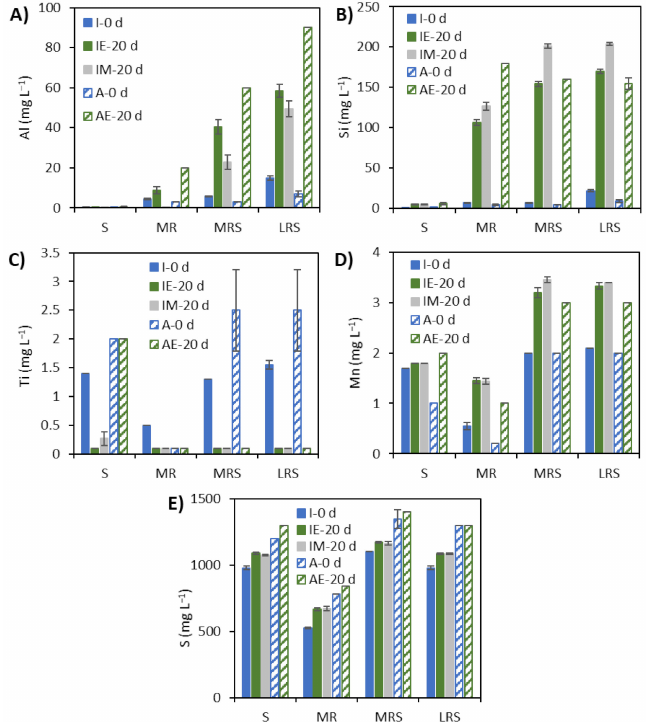
Figure 5. Concentrations of soluble metal cations: ( A ) aluminium, ( B ) silicon, ( C ) titanium, ( D ) manganese and ( E ) sulfur in inoculated (I) and abiotic (A) FPAs after incubation for 0 and 20 days under Earth gravity (E) and simulated microgravity (M) conditions in the presence of 12.5 mM Fe 3+ (S), 1% Mars regolith simulant (MR), 1% Mars regolith simulant plus 12.5 mM Fe 3+ (MRS) and 1% lunar regolith simulant plus 12.5 mM Fe 3+ as substrates